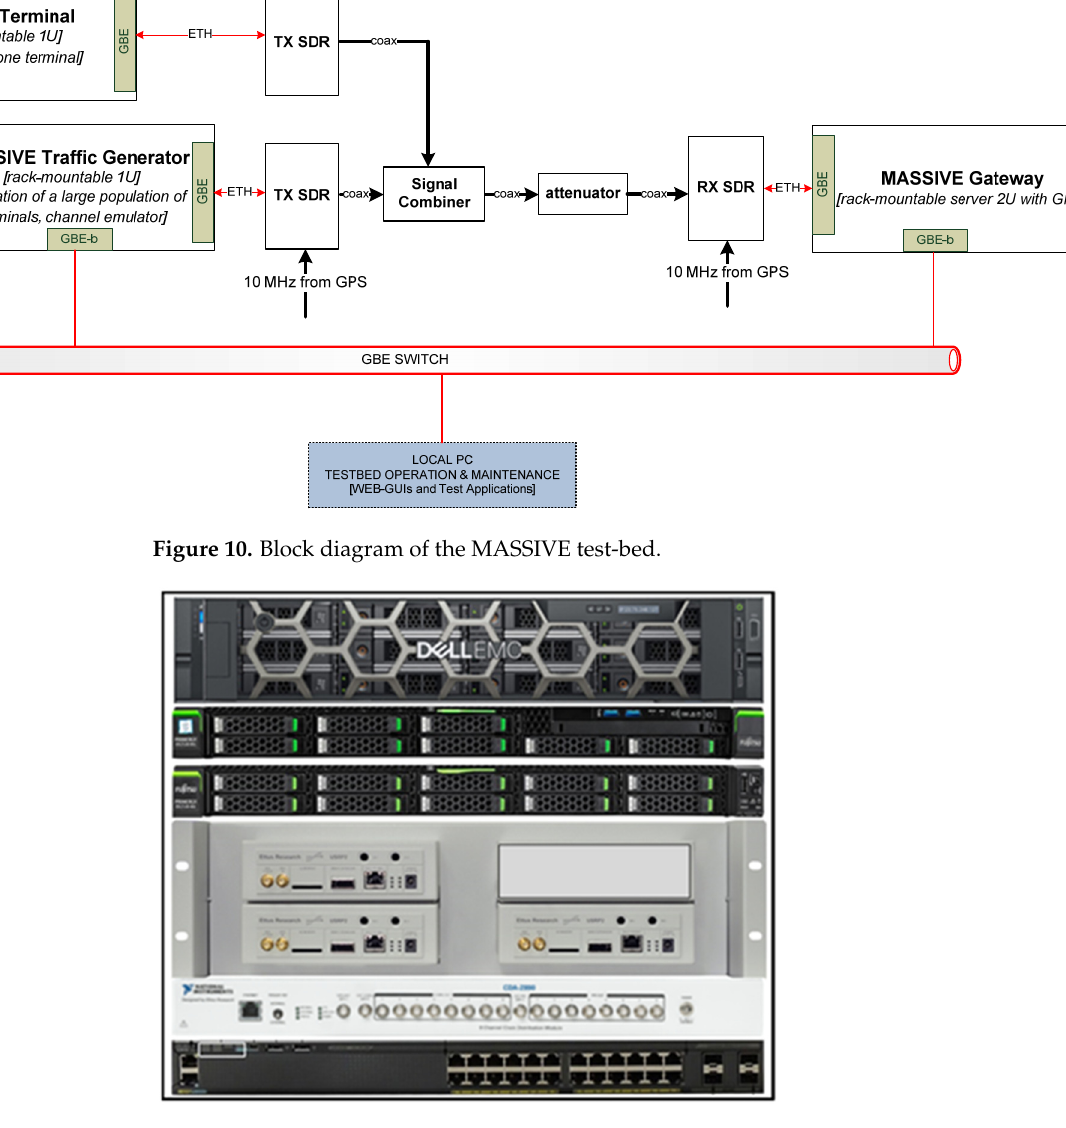
Figure 11. Real rack configuration of the MASSIVE test-bed.